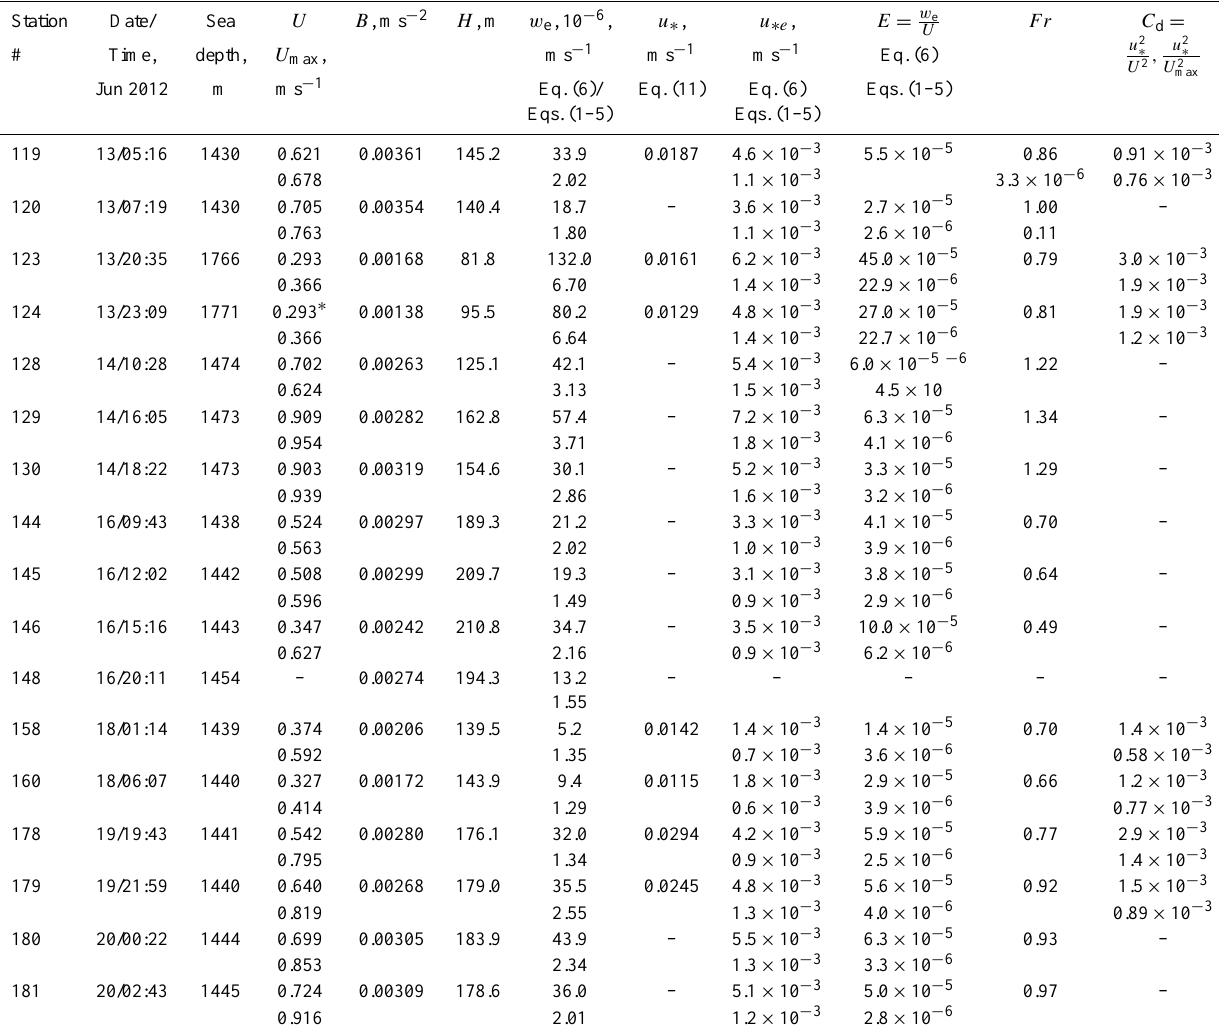
Table 1. Parameters of the overflow plume estimated at different